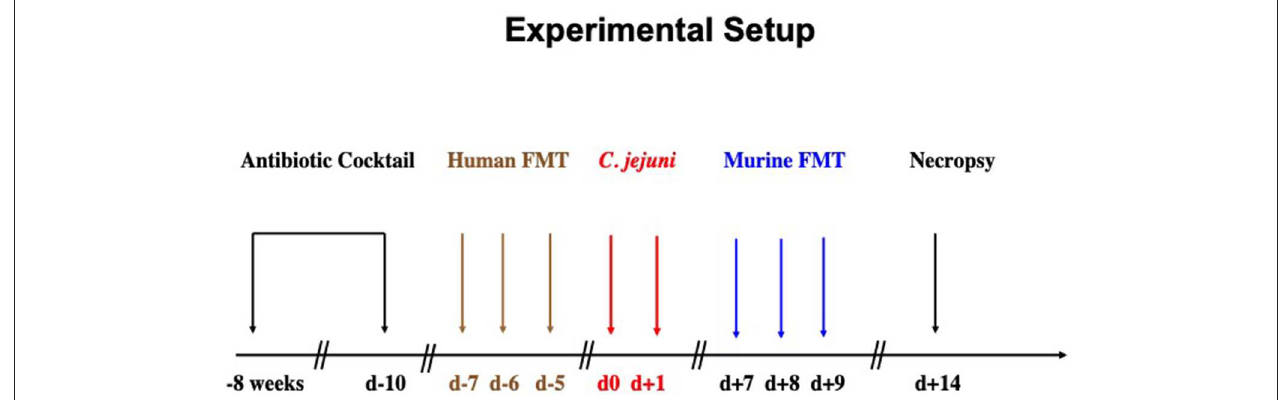
FIGURE 1 | Experimental setup. Secondary abiotic mice were generated by broad-spectrum antibiotic treatment for 8 weeks. Three days before human fecal microbiota transplantation (FMT) the antibiotic cocktail was replaced by sterile tap water to guarantee antibiotic washout. Microbiota depleted mice were then subjected to human FMT on 3 consecutive days [i.e., day (d) − 7, d − 6, d − 5]. To assure stable establishment of the human gut microbiota within the murine host, mice were kept for another 7 days before C. jejuni infection. On d0 and d + 1, human microbiota associated (hma) mice were perorally subjected to C. jejuni by gavage. One week later, C. jejuni infected hma mice were treated with oral FMT derived from murine donors (d + 7, d + 8, d + 9) and surveyed until necropsy on d +